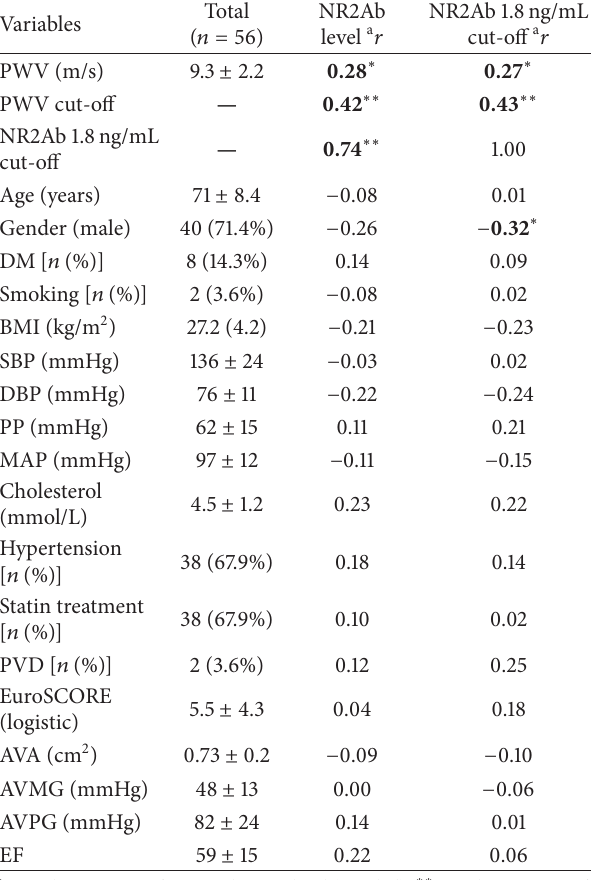
Table 1: Demographic and clinical characteristics and their correla- tion with NR2Ab level and NR2Ab 1.8 ng/mL cut-off.